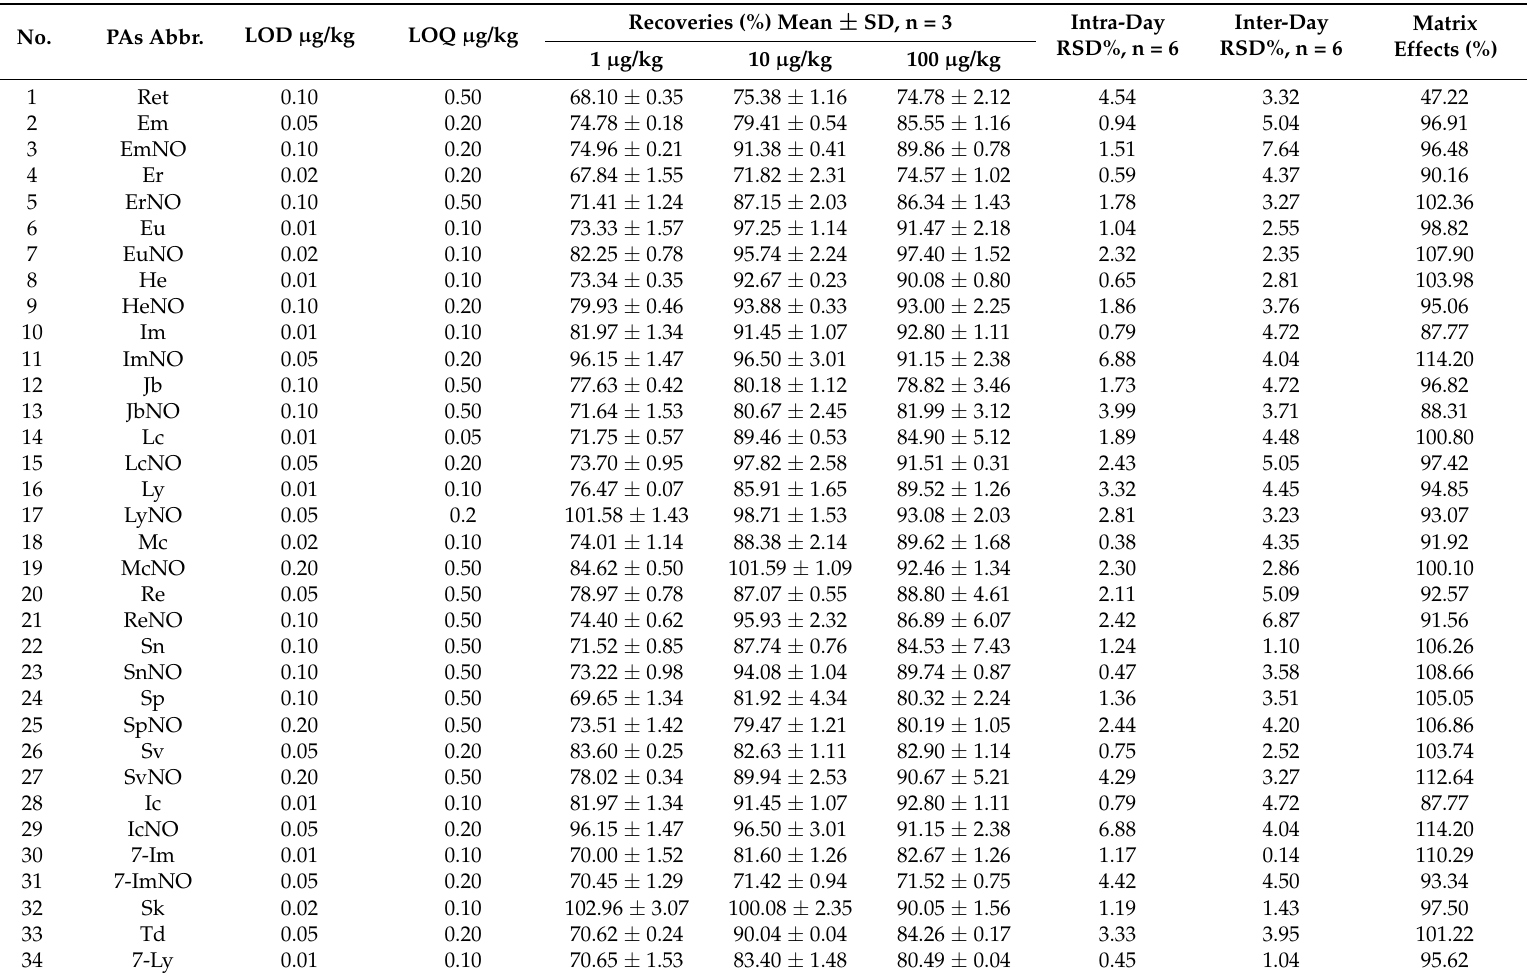
Table 1. Limit of Detection (LOD), Limit of Quantification (LOQ), recoveries, Intra-day and Inter-day repeatability obtained by UPLC-MS/MS